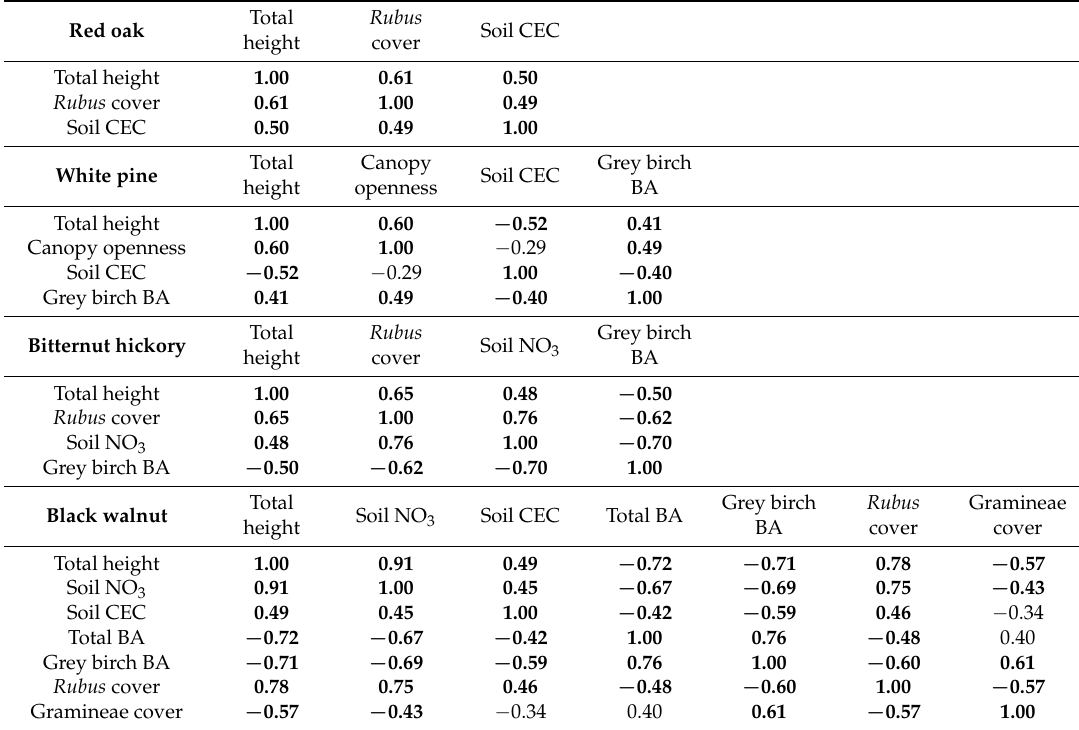
Table A2. Correlation matrix between total height after 6 years for the four studied tree species and selected ecological